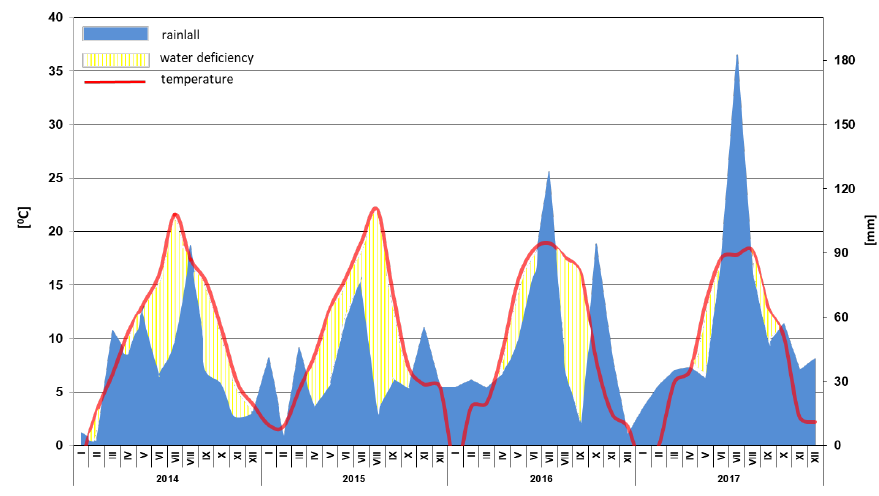
Figure 1. The climatogram in the years